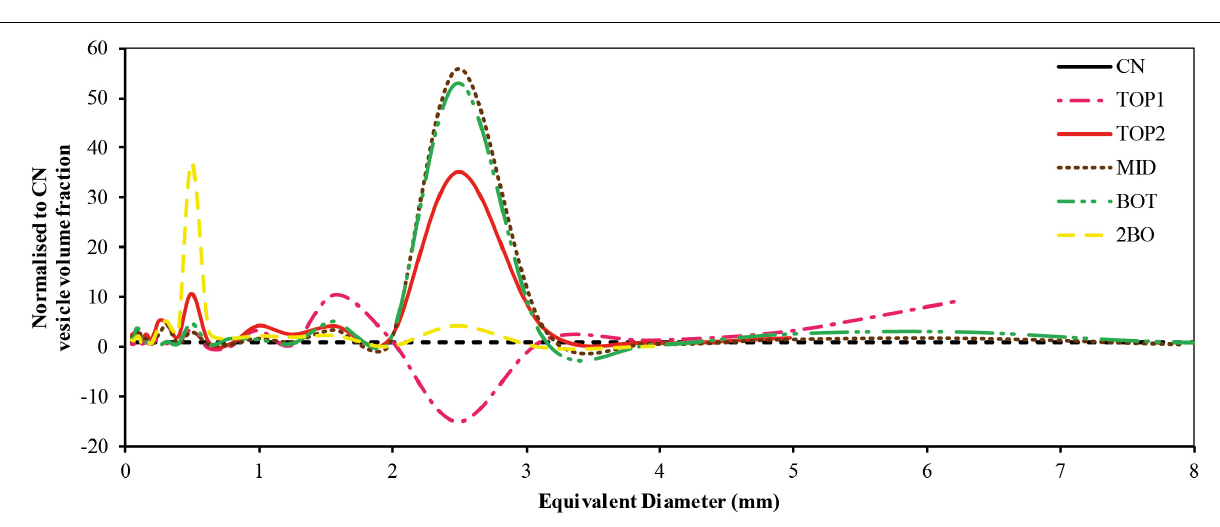
FIGURE 6 | Cumulative vesicle size distribution normalized to the control sample (CN). Most of the samples show an enrichment in vesicle size between 2 and 3 mm. TOP1 has seen a coalescence phenomenon which explains the depletion in the 2–3 mm range and increase > 5 mm (Thivet et al.,